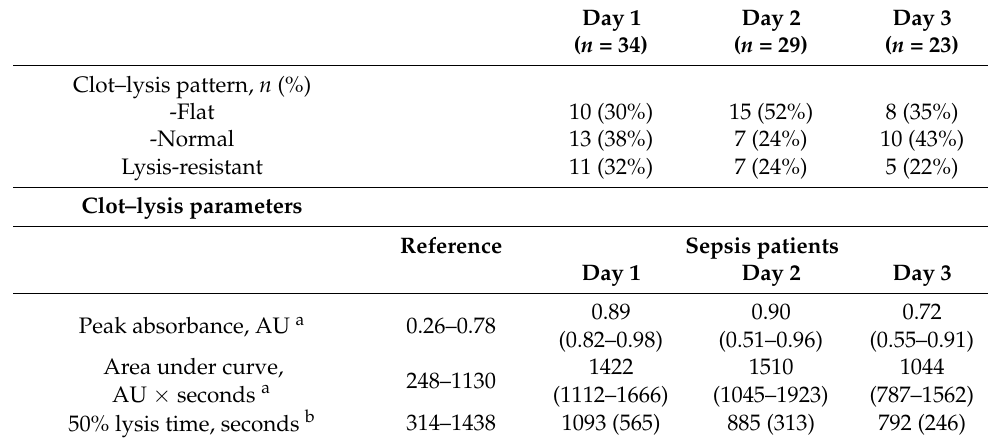
Table 3. Patients with flat, normal or lysis-resistant fibrin formation curves on days 1, 2 and